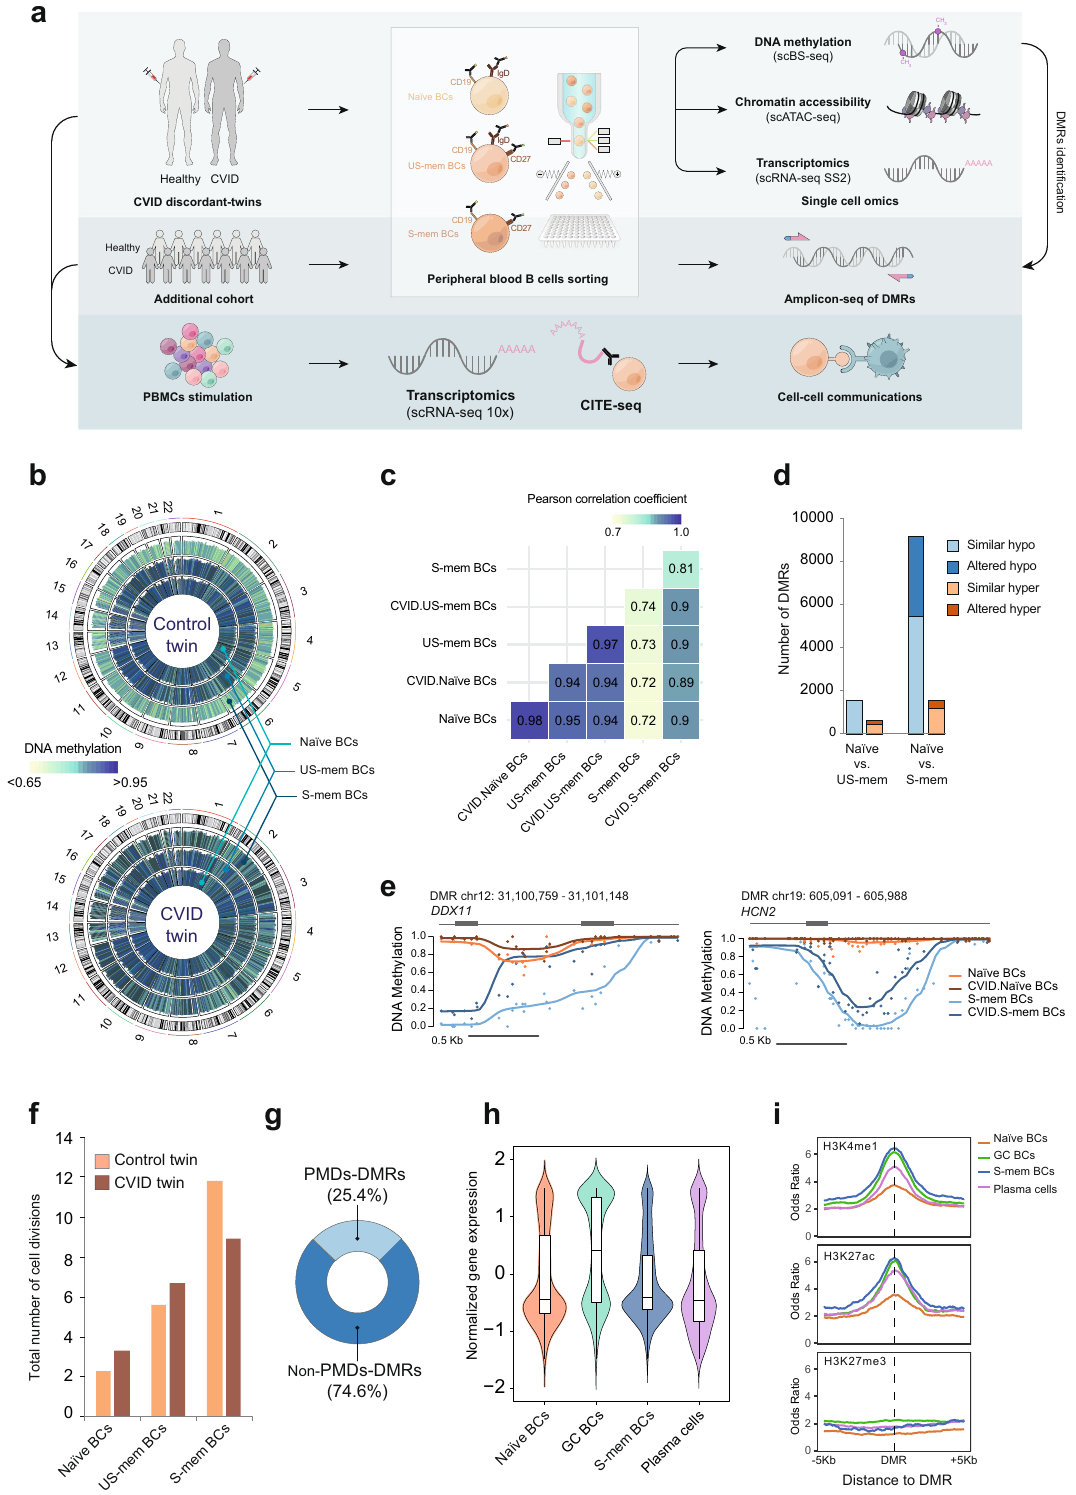
affected DNA methylation loss and occurred in S-mem B cells, we demeth DMRs hereafter for brevity (Supplementary Data 5). A high proportion of the DNA demethylation taking place during cell differentiation occurs in genomic regions named late replication and passive demethylation 22,23 . To test whether